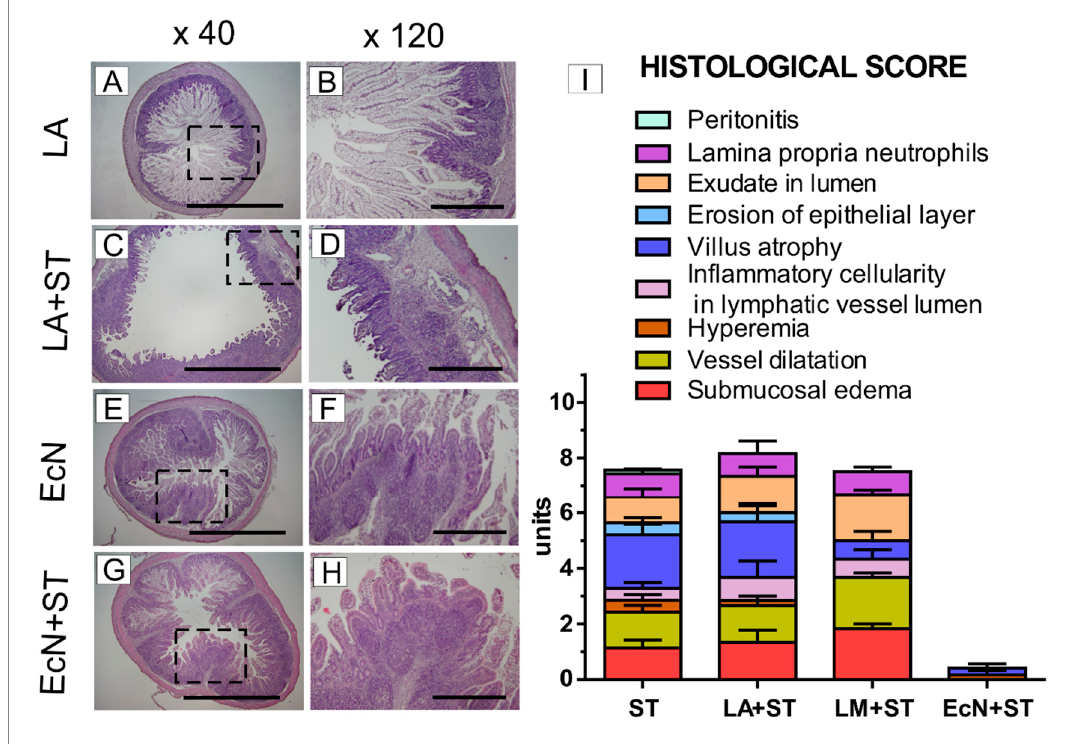
Figure 4. Representative hematoxylin- and eosin-stained cross sections of the ileum in the gnotobiotic piglets and a histological score. The piglet colonized with L. amylovorus (LA; A,B ), the piglet colonized with L. amylovorus and infected with S . Typhimurium for 24 h (LA+ST; C,D ), the piglet colonized with E. coli Nissle 1917 (EcN; E,F ), and the piglet colonized with E. coli and infected with S . Typhimurium for 24 h (EcN+ST; G,H ). No obvious differences were observed between the GF, LA, and LM groups; thus, LA represents these three groups. Bars represent 1 mm (A,C,E, and G) and 500 μ m (B,D,F, and H) cross sections, respectively. Histological scores from the ileum of six piglets per group are depicted ( I ).